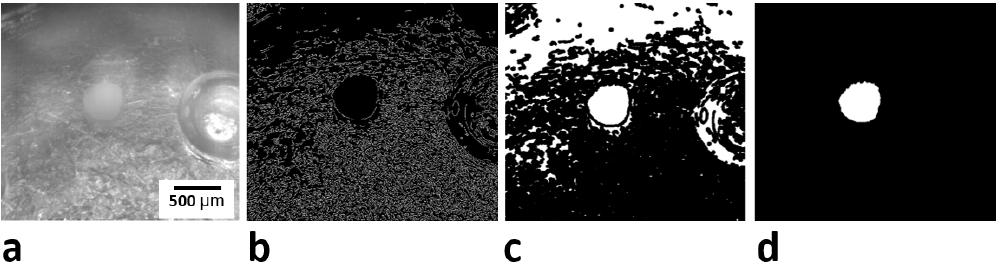
Figure 7. ( a ) HT-CSLM microscopy image of the alumina inclusion suspended in the slag at a temperature of 1600 ◦ C and time 525.15 s. ( b ) Image of the inclusion after running the Canny edge detection method on Figure 4a. ( c ) Image after the dilation of edges in Figure 4b and binary color complement procedure. ( d ) Morphologically constructed inclusion after removing regions connected to boundaries of the picture and the regions outside the circularity threshold.